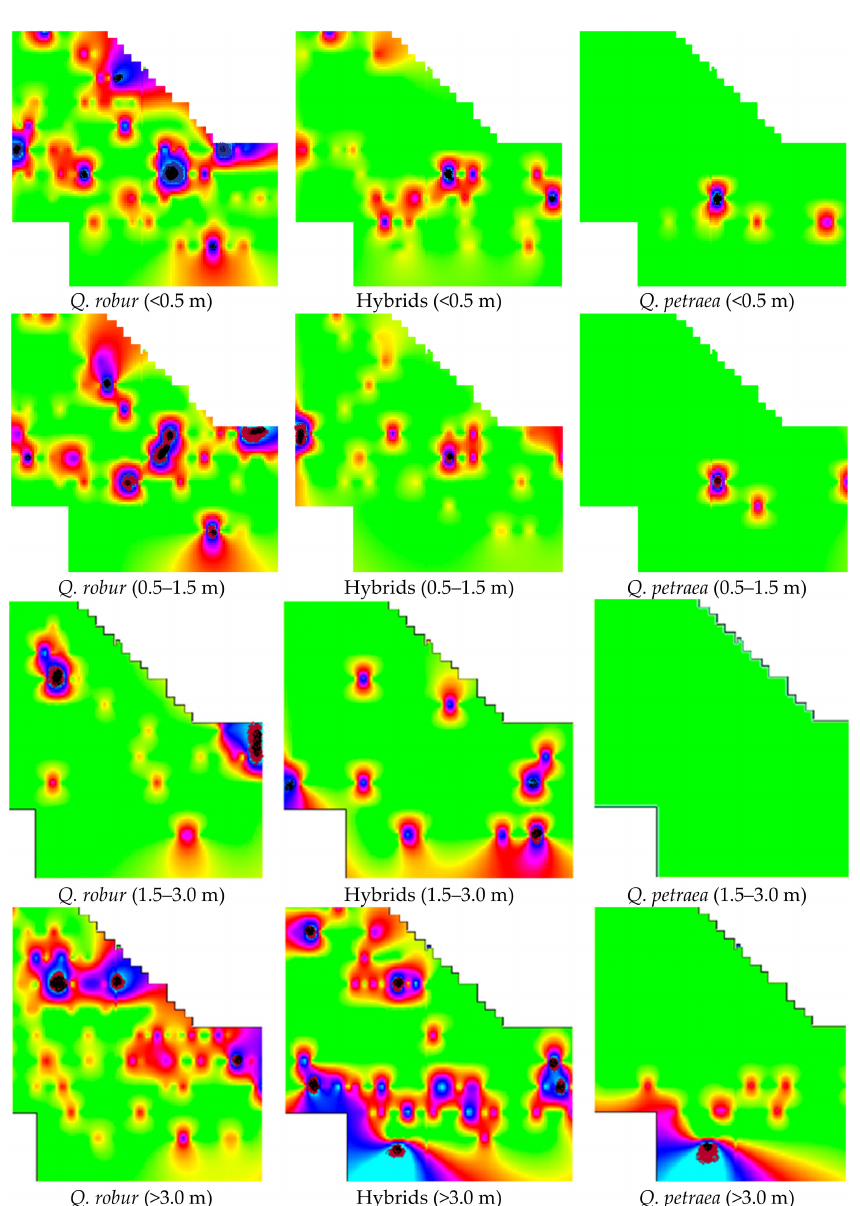
Figure 2. Oak undergrowth distribution by height groups and species. Brightest colour indicates an area where there is no oak undergrowth. Different colours indicate differing numbers of oaks in the plots. The plot area is 78.5 m 2 . The largest number of oak undergrowth in the group up to 0.5 m height was: for Q. robur , 26; hybrids, 15; Q. petraea , 17. Respectively, in the group with height 0.5–1.5 m: 13, 13, 3; in the group of 1.5–3.0 m height: 10, 2, 0; and in the group with height over 3.0 m: 10, 3,